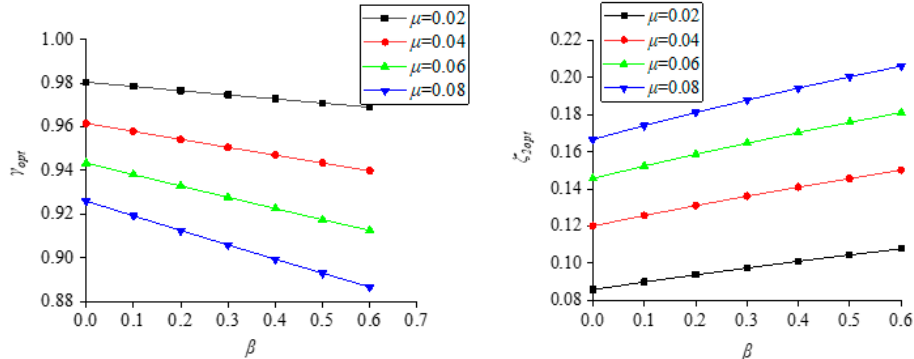
Figure 7. Optimal design parameters for ground TMDI.